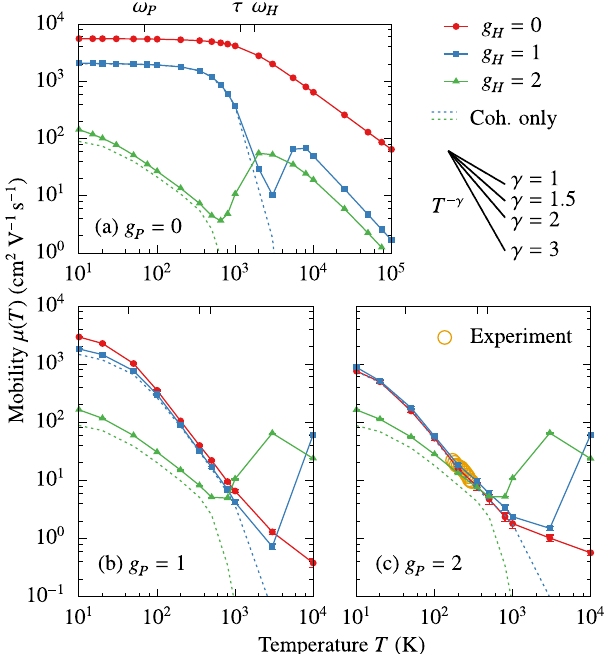
0 , (a)] FIG. 3. dc (zero-frequency) mobility with zero [ g P ¼ 1 , (b)], and Peierls coupling, moderate Peierls coupling [ g P ¼ 2 , (c)] and various Holstein strong Peierls coupling [ g P ¼ coupling. The top axis marks the major energy scales of the model, i.e., Peierls frequency ( ω ), Holstein frequency ( ω ), and P H the bare nearest-neighbor hopping τ . The dashed lines show the coherent component of the mobility, where the Holstein coupling is evident only through the renormalized electronic energy ˜ τ . Panel (c) compares to the rubrene b -axis Hall effect hole mobility measurements from Ref. [7]. A Gaussian broadening of 0.25 meV is used in all calculations to converge the conductivity at zero frequency; all other parameters are the same as in Fig. 1. Below the key on the top right, we plot idealized power laws T − γ for visual